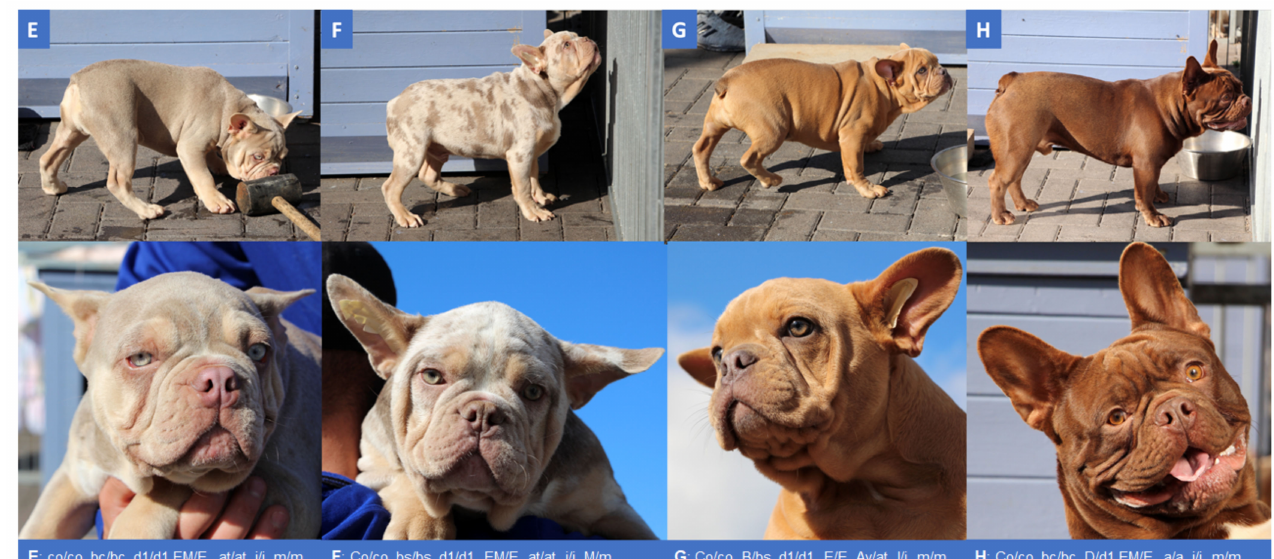
Figure 1. Different coat color and pattern phenotypes of French Bulldogs, depending on genotypes at HPS3 in combination with different genotypes at TYRP1, MLPH, MC1R, ASIP, MFSD12 and PMEL genes. Genotypes at the underlying loci are indicated (see Table S1). ( A ) Cocoa and tan dog with dark brown eumelanin, yellow pheomelanin markings, dark brown nose and light brown eyes. The muzzle is dark brown, due to dominant EM allele at MC1R . Note the intense yellow markings; pheomelanin has not been diluted by co / co . ( B ) TYRP1 -related brown and tan dog with brown eumelanin, light yellow pheomelanin markings, brown nose and yellow eyes. ( C ) Dilute cocoa plus brown and tan dog with greyish-brown eumelanin, yellow pheomelanin markings, greyish-brown nose and light green eyes. ( D ) Pale yellow dog due to the dominant yellow Ay allele at the ASIP gene. Cocoa plus brown eumelanin can be seen around the muzzle due to the presence of EM at MC1R . The dog has a greyish-brown nose and yellow eyes. ( E ) Dilute cocoa plus brown and tan dog with greyish-brown eumelanin, pale yellow pheomelanin markings, greyish-brown nose and light green eyes. Note the slightly paler markings than in C, due to the genotype i/i at the MFSD12 gene. ( F ) Dilute brown and tan dog with pale yellow markings, greyish-brown nose and light green eyes. Greyish-brown muzzle due to EM at MC1R . Eumelanin is further diluted in random areas, creating a pattern of greyish-brown patches in different shades on body, upper parts of legs, neck and head, due to the presence of the dominant Merle allele ( M ) at PMEL . ( G ) Intense yellow dog with greyish nose and light brown eyes. Compare the intense pheomelanin color to the pale yellow of D, due the genotype i / i at MFSD12 . ( H ) TYRP1 -related brown dog with brown nose and brown eyes. Phenotypical differentiation between co/co B/- (cocoa) and Co/- b/b (brown) is most reliable in dogs with a large proportion of eumelanin (e.g., black and tan or solid black base color, see A, B and H) and no other eumelanin diluting and/or attenuating genotypes (e.g., d / d at MLPH ). Coat, nose and eye color phenotypes are influenced by different gene loci. The genotype b / b d / d affected the phenotype of co / co dogs by further diluting eumelanin from dark brown to greyish brown ( C , E , F ). Note: It is not possible to reliably differentiate co/co from Co/- phenotypically, if further eumelanin reducing (e.g., Ay at ASIP ) (see ( D , G )) and/or eumelanin attenuating (especially TYRP1 and/or MLPH ) (see ( C , E – H )) alleles are